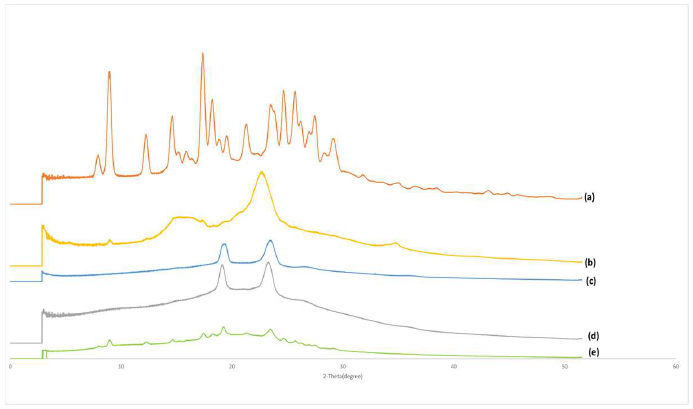
Figure 7. XRD spectra of ( a ) commercial curcumin powder, ( b ) Soluplus ® , ( c ) Vitamin E TPGs, ( d ) Formulation A, and ( e ) the physical mixture of Formulation A.